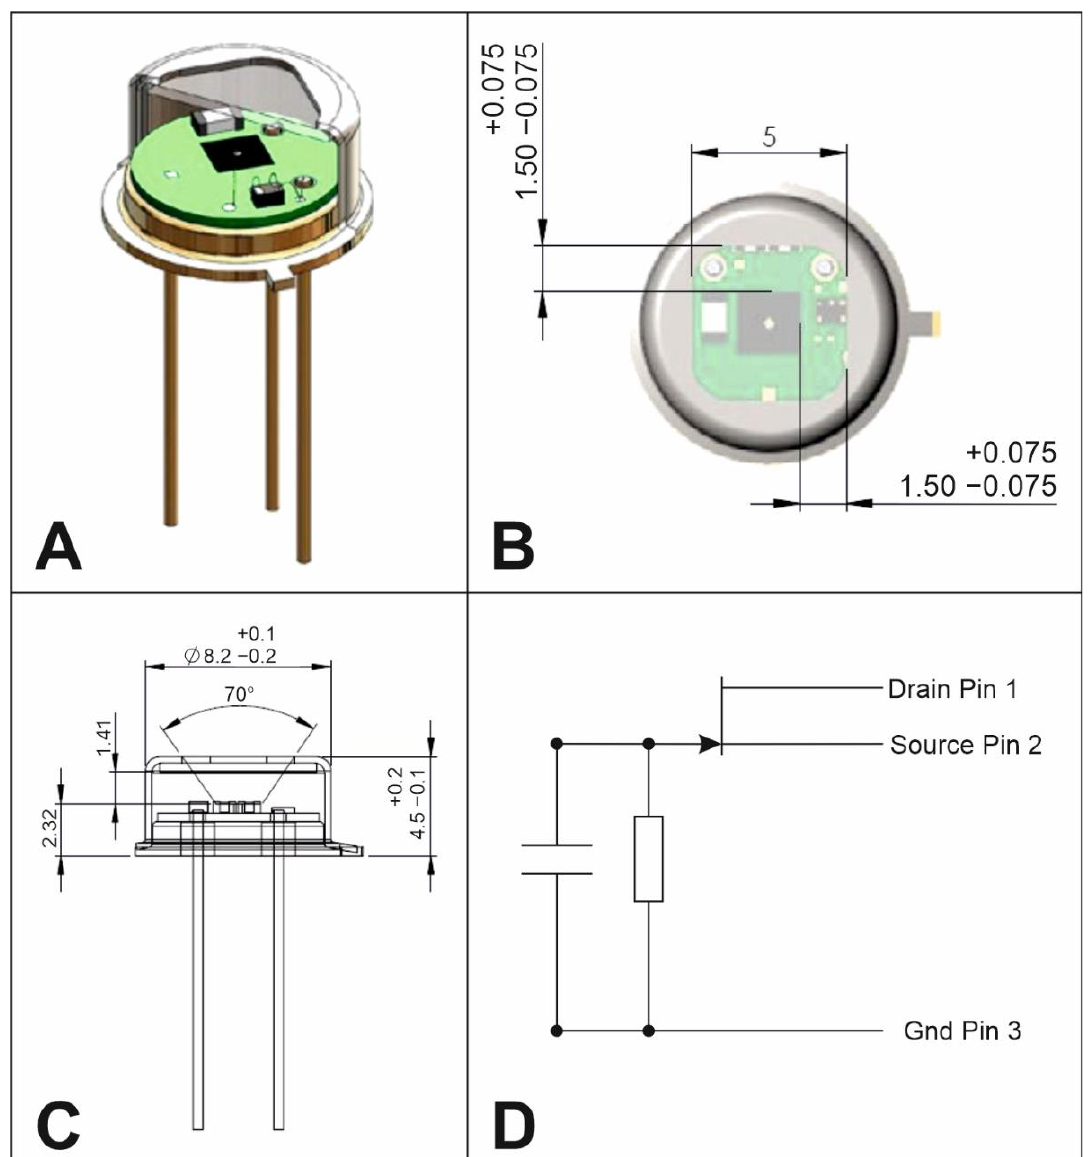
Figure 11. ( A ) Three-dimensional cross section of pyroelectric detector L3100 × 2020, followed by its horizontal ( B ) and vertical ( C ) cross sections. All reported distances are in mm. ( D ) Circuit diagram of the detector.